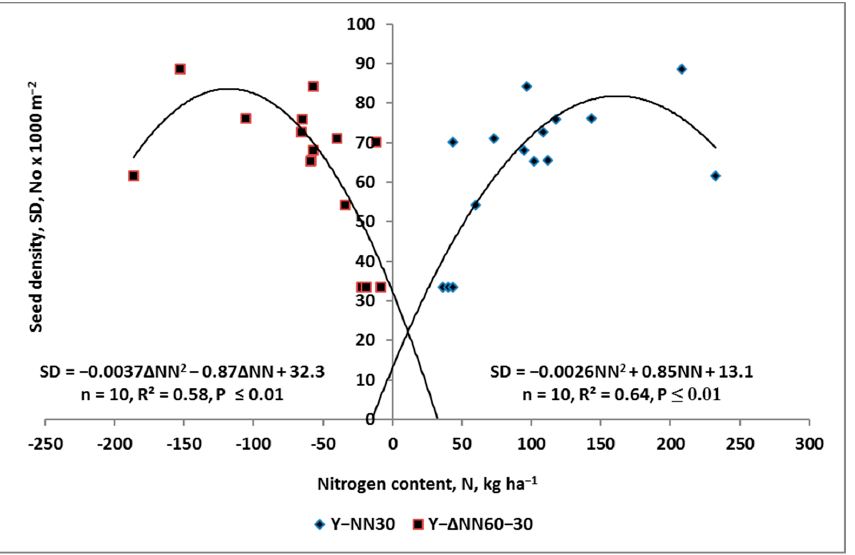
Figure 5. A conceptual pattern of dry matter accumulation by a typical seed/grain crop. Legend: CK1, CK2—cardinal stage 1 and 2, respectively (author’s own concept).